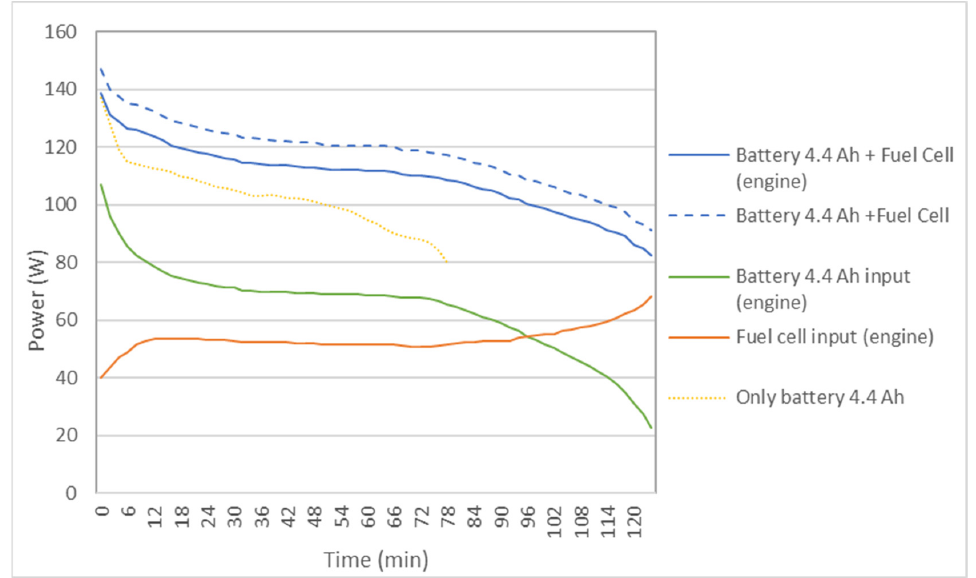
Figure 6. Comparison of the power delivered to the bicycle by the 4.4 Ah auxiliary battery, acting alone or in a hybrid way with the FC, in the case of a reactor.